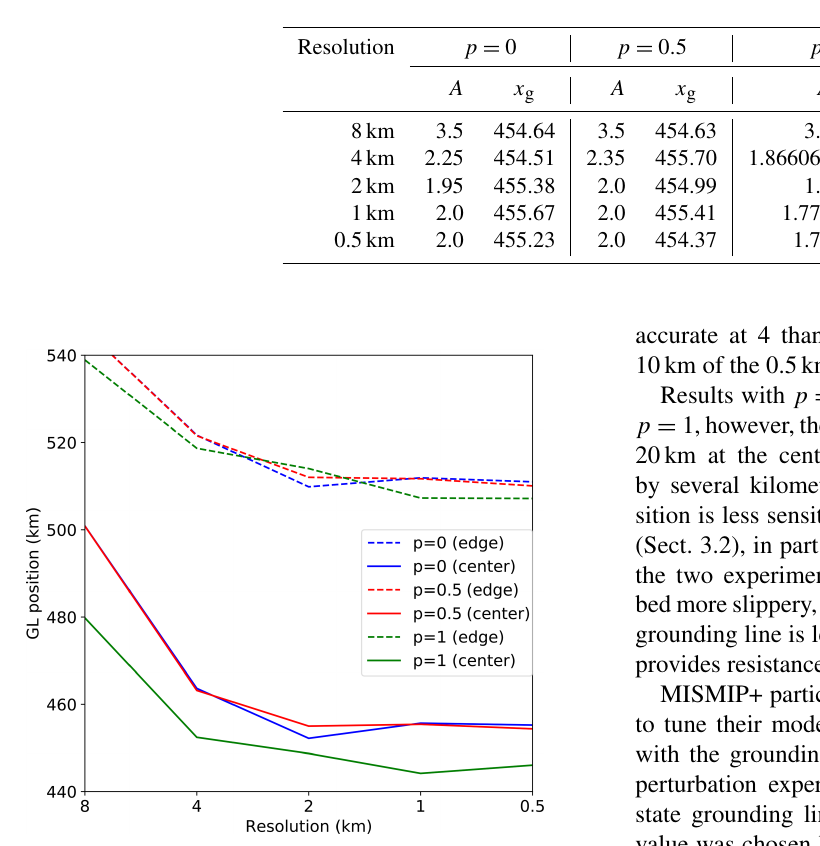
Table 3. Ice softness A (10 − 17 Pa − 3 yr − 1 ) and resulting grounding line position x g (km) for melt experiments at the end of the spin-up. Note that the A values are not truncated.